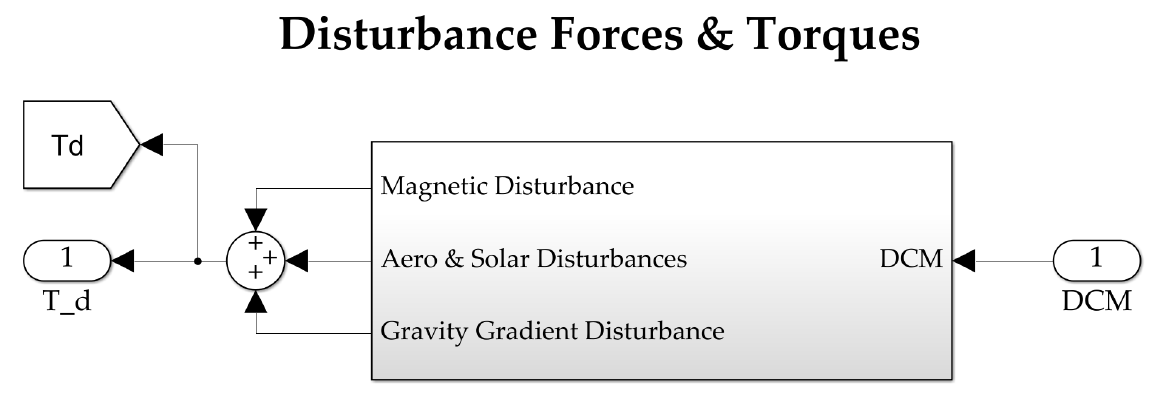
Figure A9. MatLab model with complete detailed display of the spacecraft disturbances Simulink subsystem.